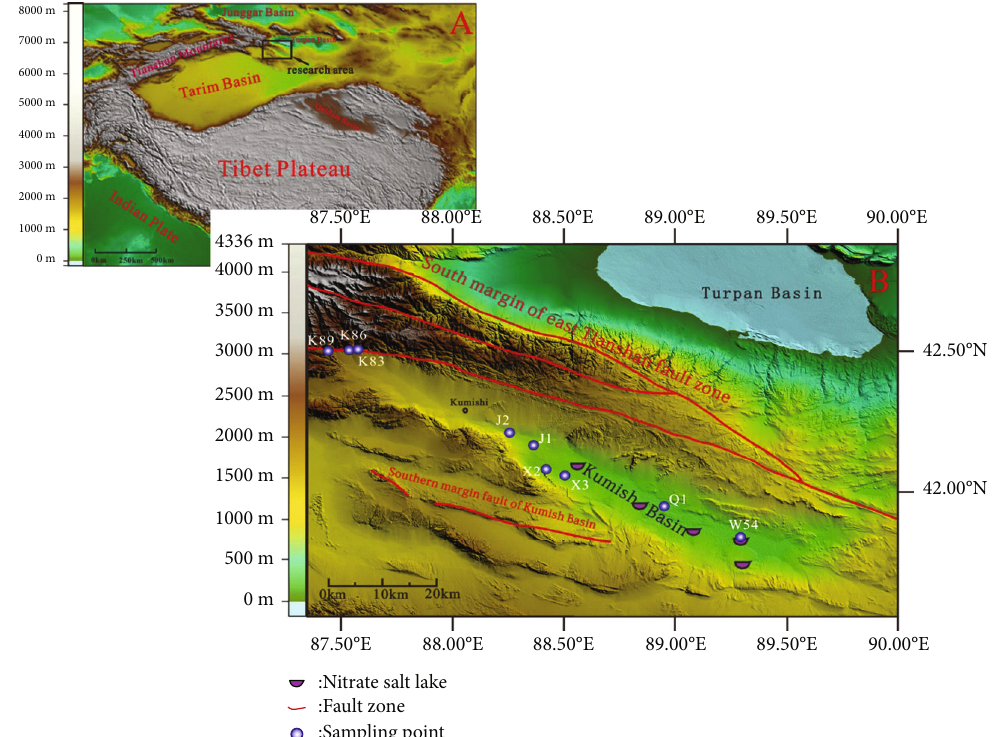
Figure 1: Geographical map of the study area. (a) Geographic location of the study area in China. (b) The geographic location of the water sampling